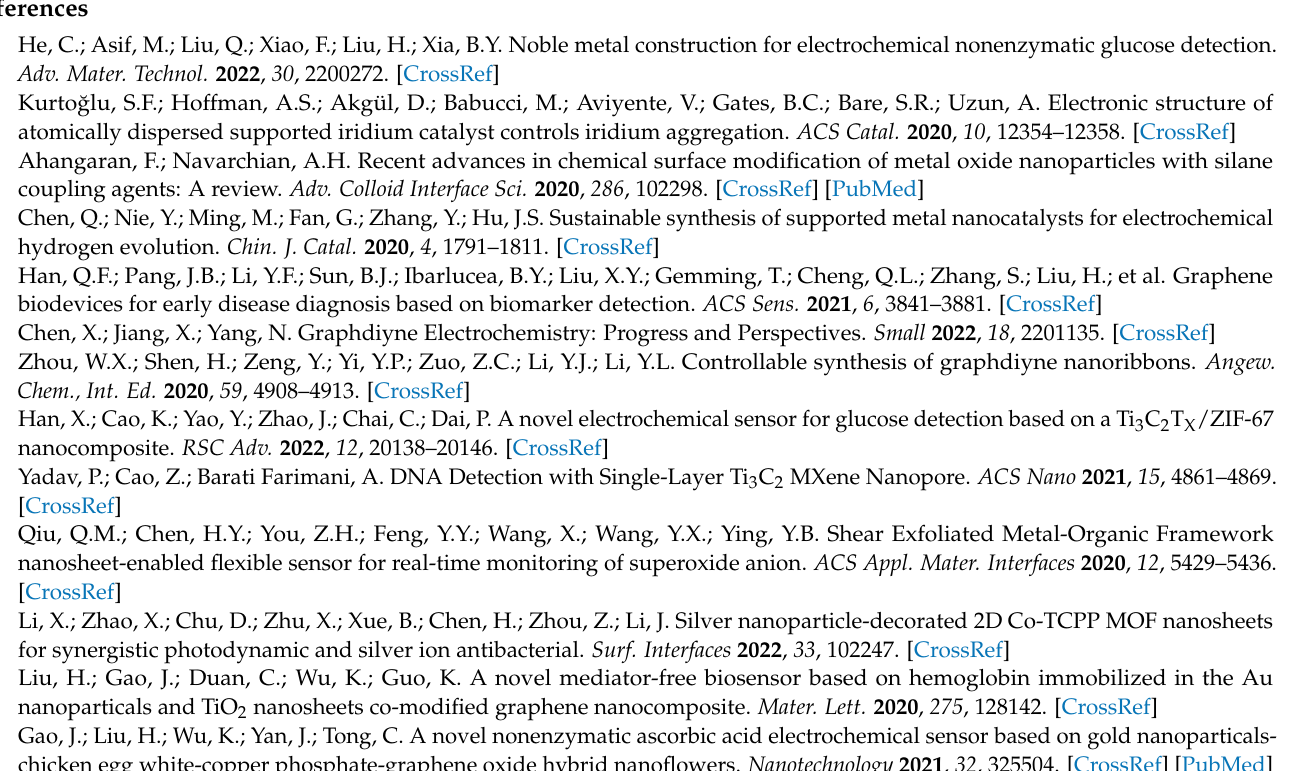
(pH = 7.0) to the detection of FZ. (B) Fitting curve between current density and different scan rates; Figure S7. (A) Selectivity of the CuNPs/CN/GCE for FZ detection; Figure S8. (A) Stability of the Table S1: Comparison of the sensor based on based on MNPs/CN nanozymes to other DA and UA sensors; Table S2: Comparison of the sensor based on based on MNPs/CN nanozymes to other FZ